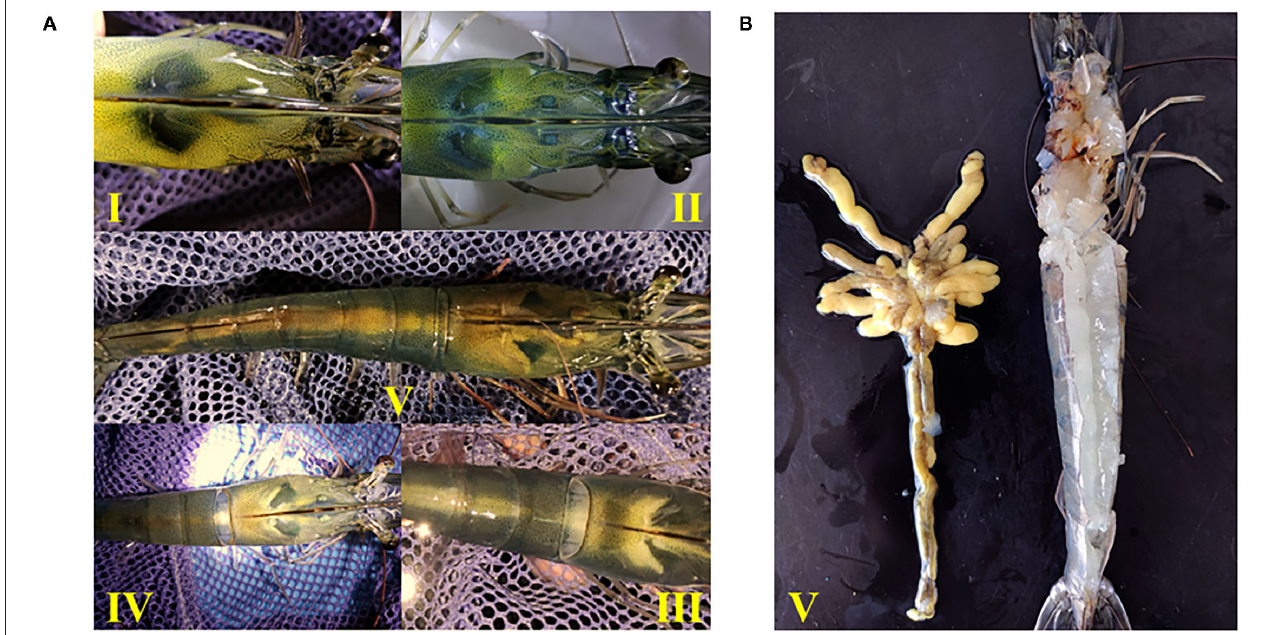
FIGURE 1 | Ovary morphology in different developmental phases of Litopenaeus vannamei . (A) Phase I-V of ovarian development. I, the ovary is transparent and linear; II, the ovary is translucent or white. III, the ovary becomes enlarged and separates between the body segment and the carapace. IV, the ovary is gradually enlarged and joins between the body segment and the carapace. V, the ovary filled the whole-body segment, the carapace and the lobule extended to the ventral side. (B) Anatomical morphology of ovary in phase V.